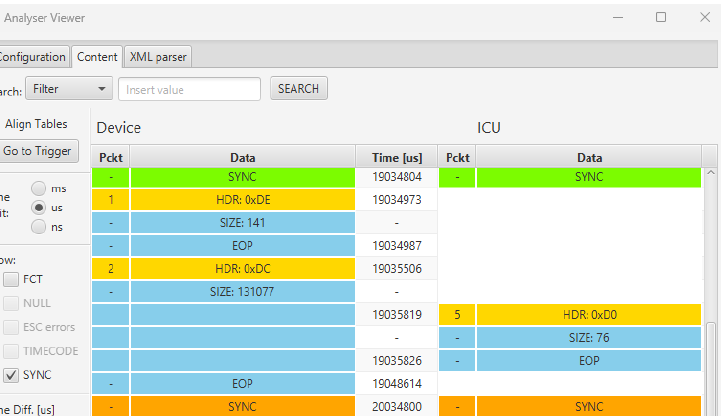
Figure 10. SpaceART Sniffer GUI partial visualization of TM1 and TM2 packets transmitted by the